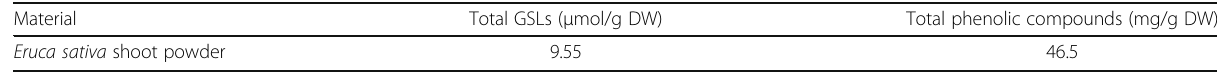
Table 1 Total glucosinolates ( μ mol/g DW) and total phenolic contents (mg/g DW) in E. sativa shoot powder